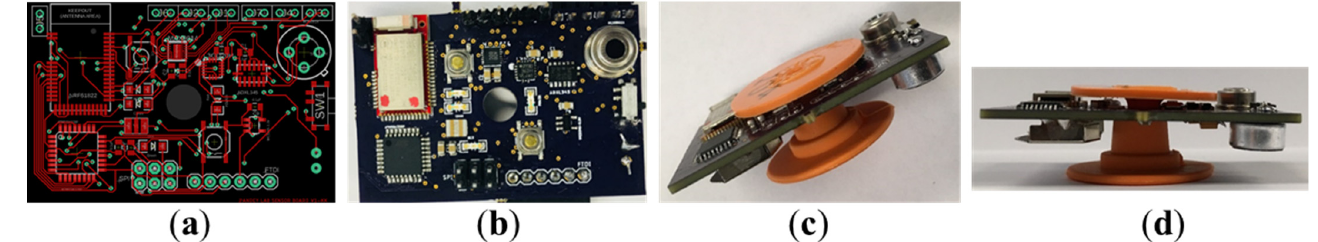
Figure 2. Prototype design and assembly: ( a ) CAD layout of the electronic sensor board; ( b ) the fabricated PCB with soldered electronic chips; ( c , d ) inclined view and side view of an assembled sensor board sandwiched between the orange-colored ear tag.